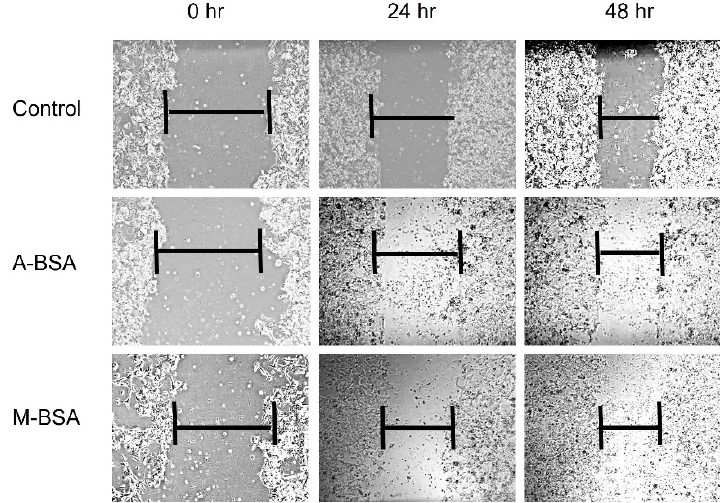
Figure 13. In vitro wound healing analysis of A6.4-100 and M6.4-100 hydrogel films.